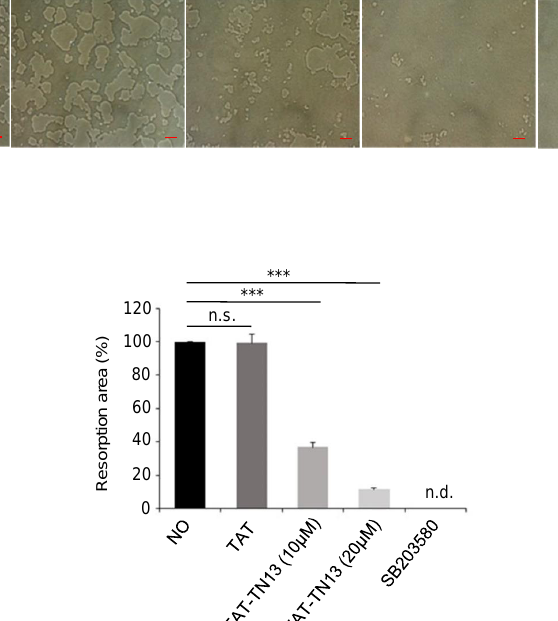
Figure 3. TAT-TN13- treated cells show reduced osteoclastic bone resorption. RAW 264.7 cells seeded into Corning Osteo Assay Surface plate and treated with different concentrations of TAT-TN13 (0, 10 and 20 µ M) in the presence of RANKL (40 ng/mL) for 4 days. Cells attached to the plates